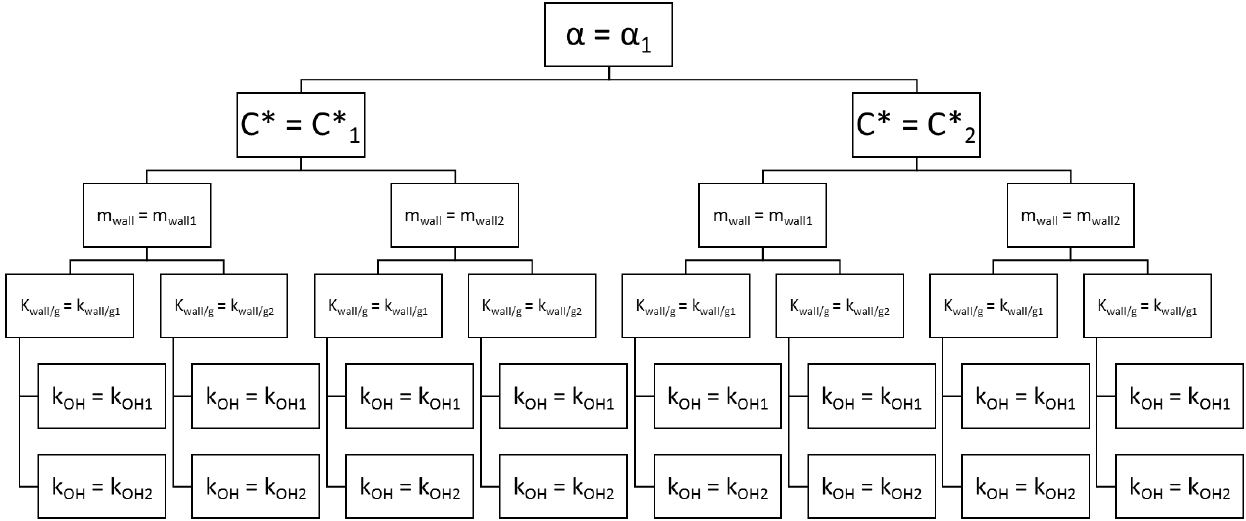
Figure 3. Illustration of the brute-force search approach applied to solve the